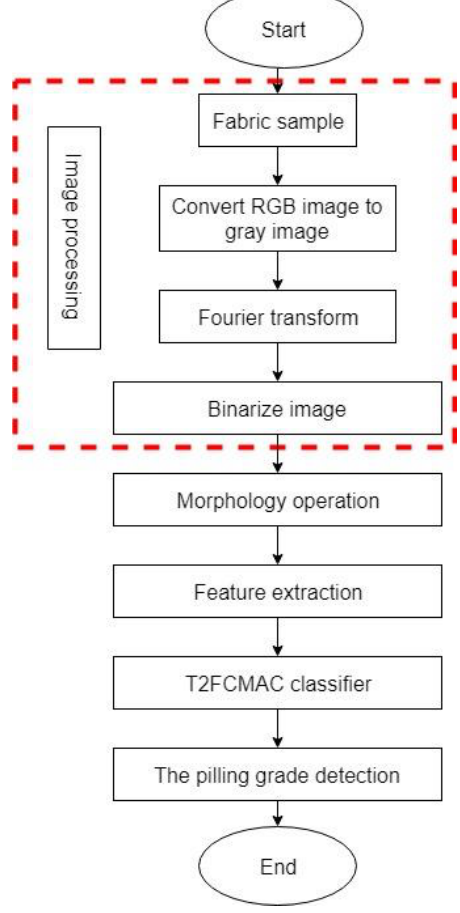
Figure 1. Flowchart of pilling grade classification of knitted fabric.